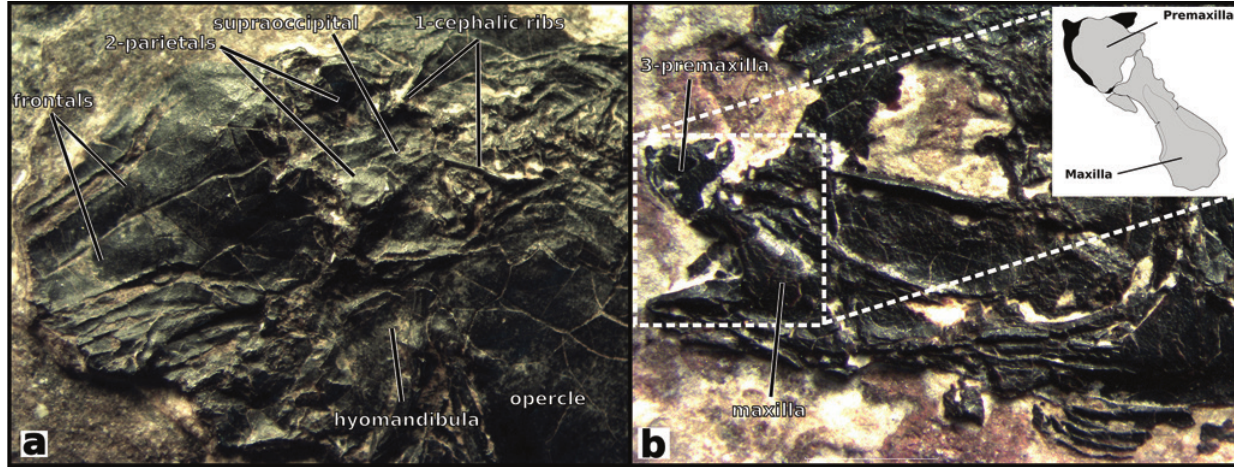
Fig. 5 . a . Dastilbe moraesi (CPUFMT 5150, 16.0 mm TFL), anterior to left. b . Dastilbe moraesi (CPUFMT 730, 30.0 mm TFL), anterior to left. Synapomorphies of Gonorynchiformes observed are: 1-cephalic ribs; 2- parietals reduced and separated by supraoccipital, 3- absence of premaxillary ascending process .